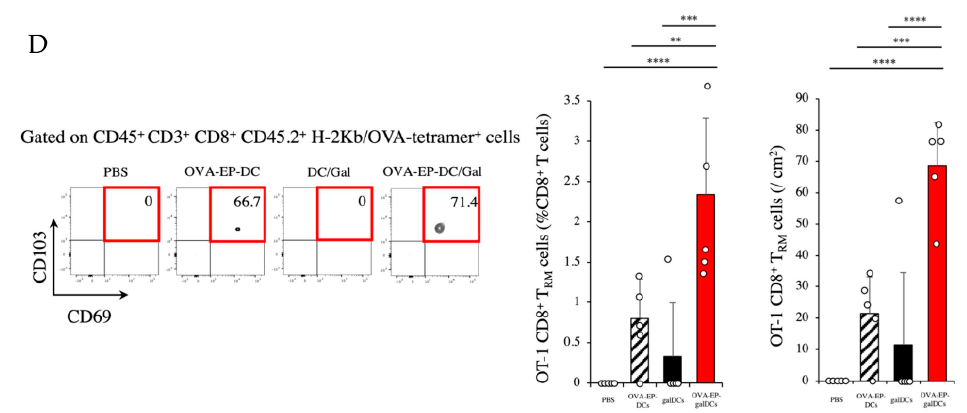
Figure 6. OVA-EP-galDCs induced OT-1 CD8 + tissue-resident memory T cells (T RM cells) in the skin. ( A ) Experimental schema is shown. C57BL/6 mice were immunized with PBS, OVA-EP-DCs, galDCs, or OVA-EP-galDCs (5 × 10 5 cells/mouse). ( B – D ) On day 14 after immunization, the frequency and the number of ( B ) CD8 + T cells (CD45 + CD3 + CD8 + T cells), ( C ) OT-1 CD8 + T cells (H-2Kb/OVA-tetrameter + CD45.2 + CD3 + CD8 + T cells), and ( D ) tissue-resident memory OT-1 CD8 + T cells (H-2Kb/OVA-tetrameter + CD45.2 + CD3 + CD8 + CD69 + CD103 + T cells; OT-1 CD8 + T RM